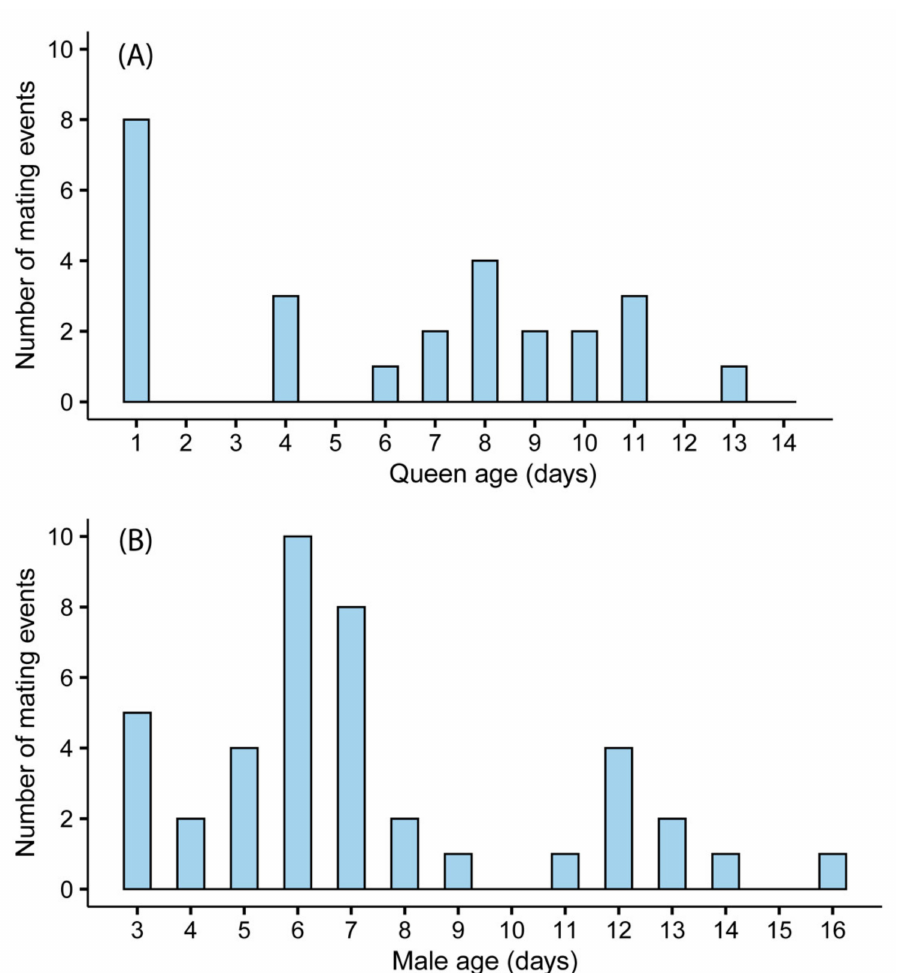
Figure 2. The impact of age on mating in Bombus impatiens queens ( A ) and males ( B ). Forty-nine queens were given the opportunity to mate daily between the ages of 1 and 14 days. Of these, 26 were successfully mated. Ninety-nine males were given the opportunity to mate daily between the ages of 3 and 16 days. Of these, 41 were successfully